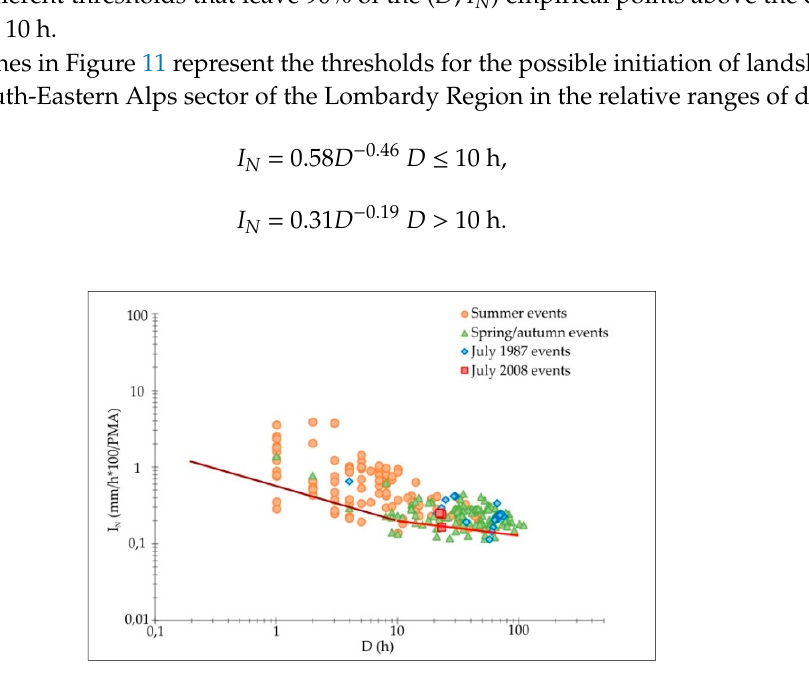
Figure 11. Rainfall events (coloured marks) that have resulted in soil slips and mud-debris flows in the Central -and South-Eastern Alps sector of the Lombardy Region in the period 1927–2008. Coloured lines represent threshold that leave 90% empirical points I N D above the curve for different range of duration (dark red, D < 10 h; light red, D > 10 h).